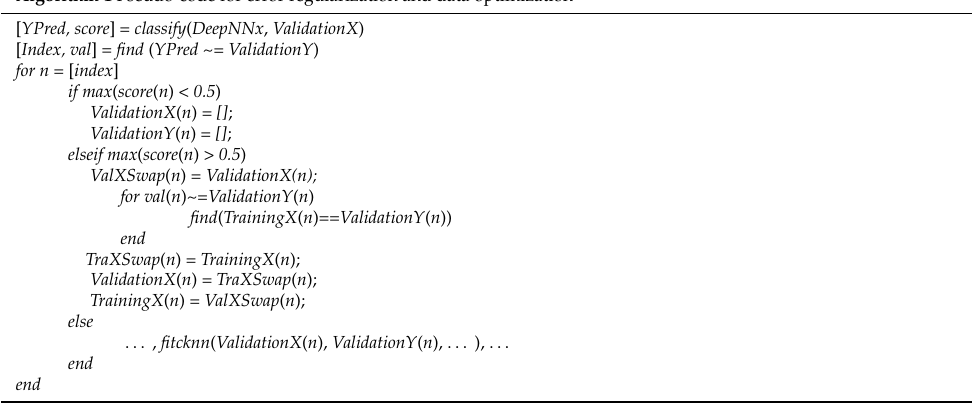
Algorithm 1 Pseudo-code for error regularization and data